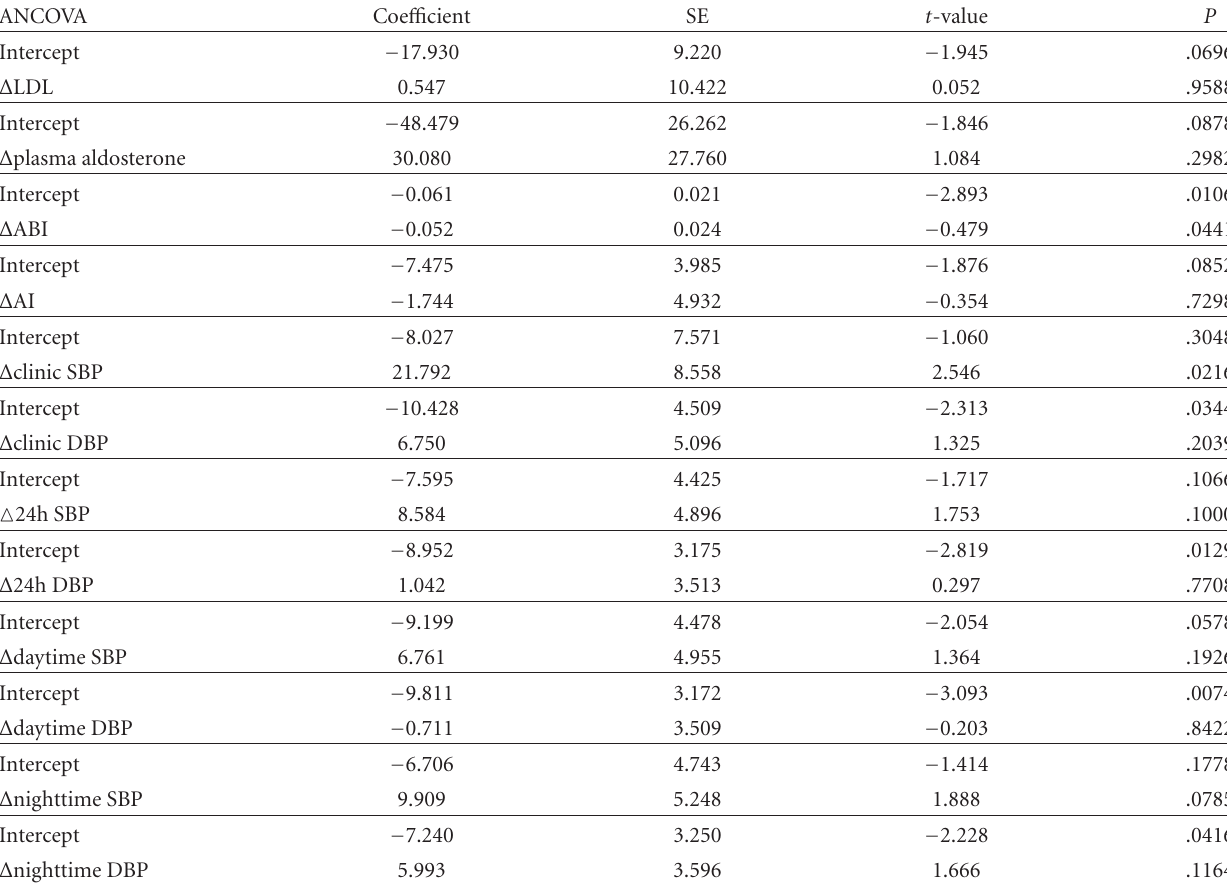
Table 3: E ff ects of percent changes in LDL-C, plasma aldosterone, ABI, AI, clinical BP, 24-h BP, daytime BP, and nighttime BP on percent changes in CAVI after combination